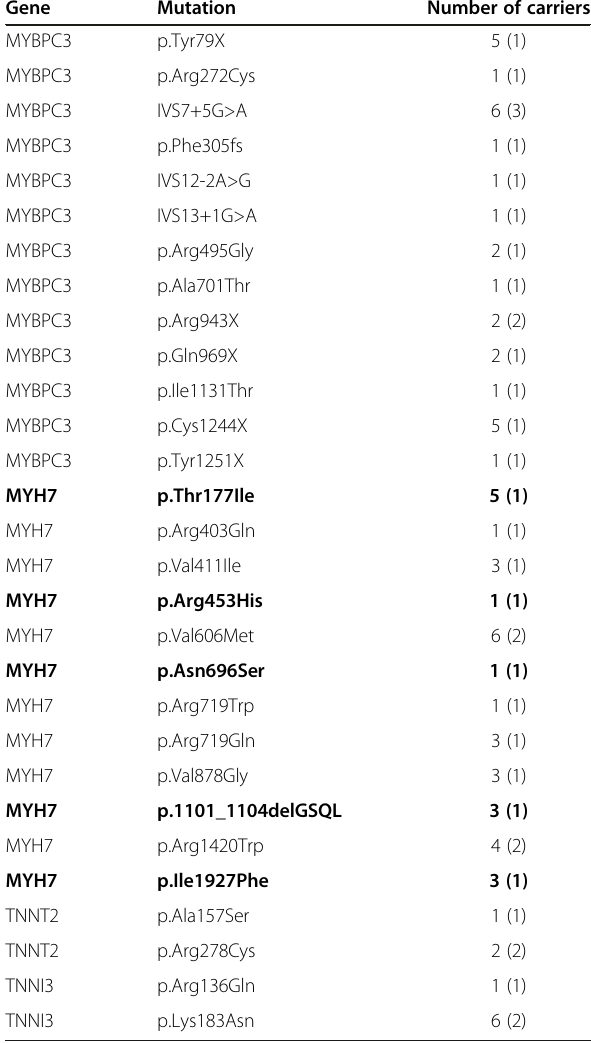
Table 1 Mutation description of group B cases (All other mutations)